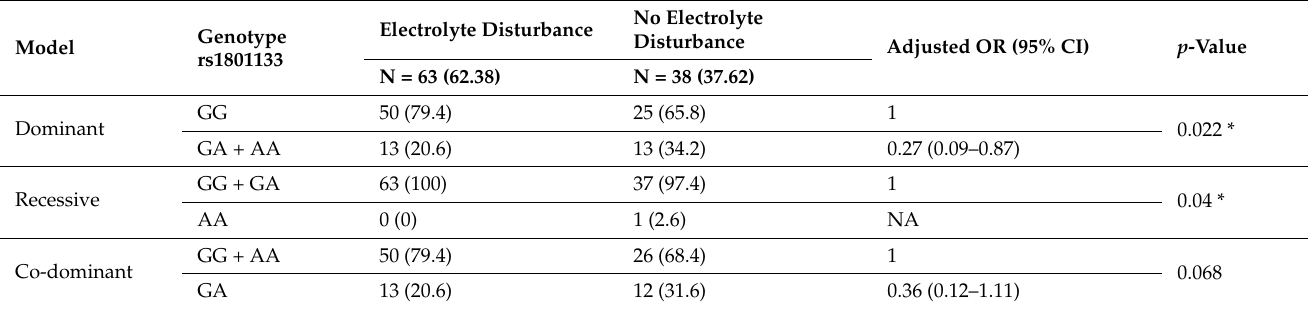
Table 7. MTHFR genotype rs1801133 and electrolyte disturbances caused by